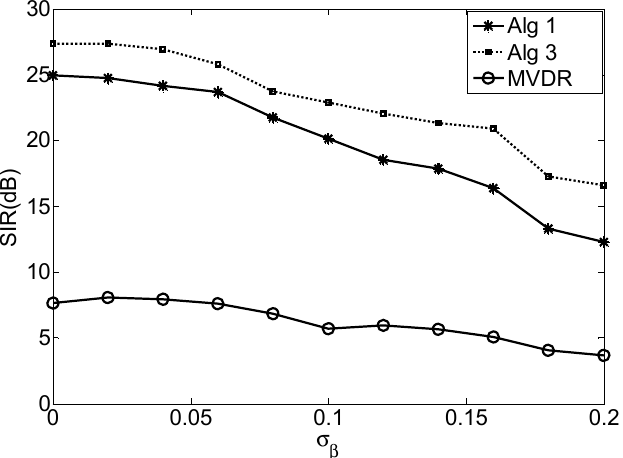
Figure 3. Comparison of the performance versus the variance of the amplitude and phase by using different